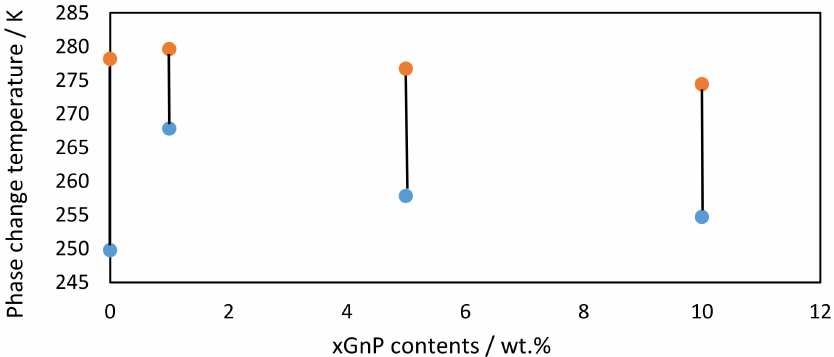
Figure 5. Phase change temperatures of pure IL and the prepared xGnP / [C 2 C 1 py][C 4 F 9 SO 3 ] at di ff erent mass concentrations where: melting point (circle —); and freezing point (circle —).